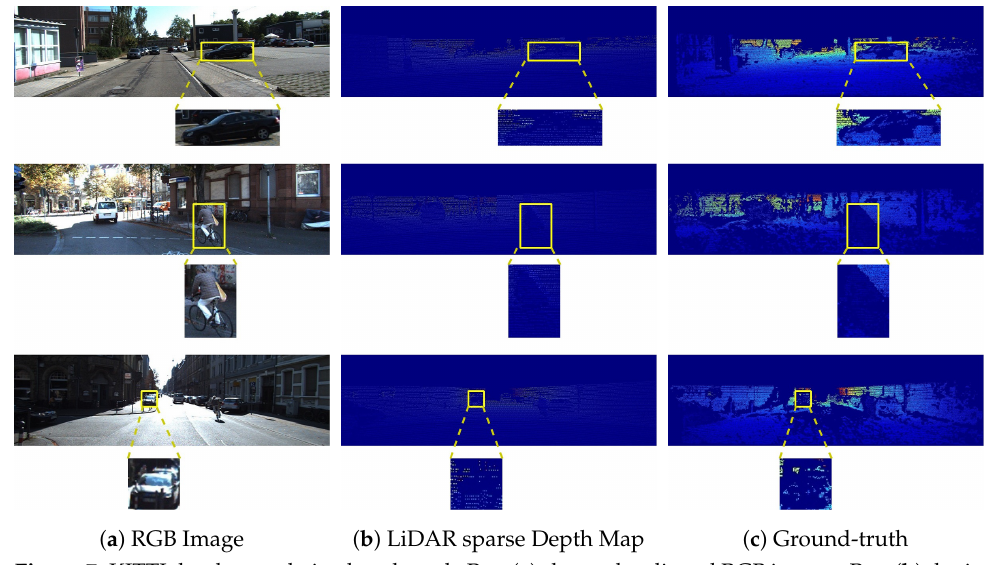
Figure 7. KITTI depth completion benchmark. Part ( a ) shows the aligned RGB images. Part ( b ) depicts the sparse LiDAR depth maps, whereas Part ( c ) represents the dense ground-truth depth maps. Col- orization is applied on LiDAR sparse depth maps and corresponding ground-truth to generate visual- izations. The highlighted areas are used to show the sparsity in KITTI depth completion benchmark.